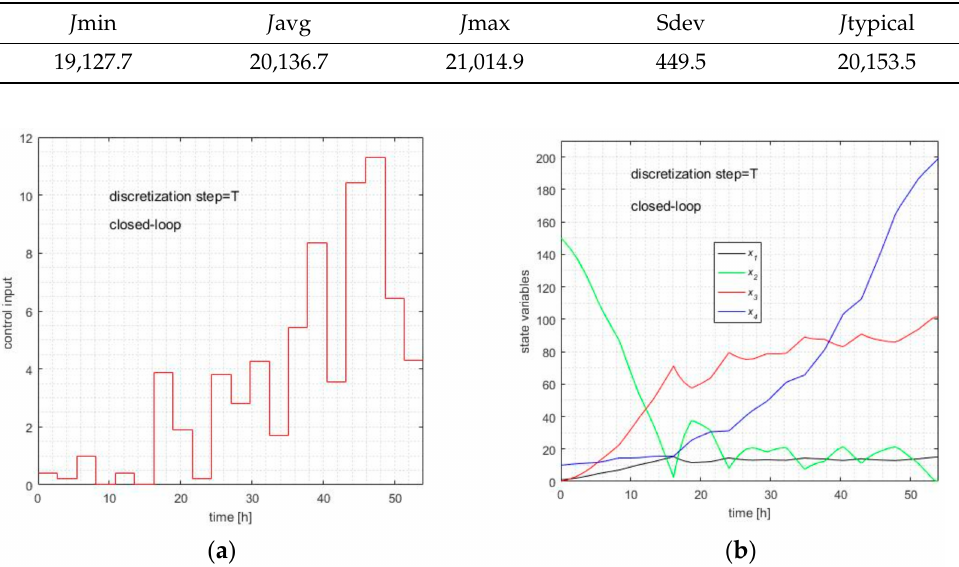
Table 6. Results of the closed-loop simulation series using the Controller with EAv1.